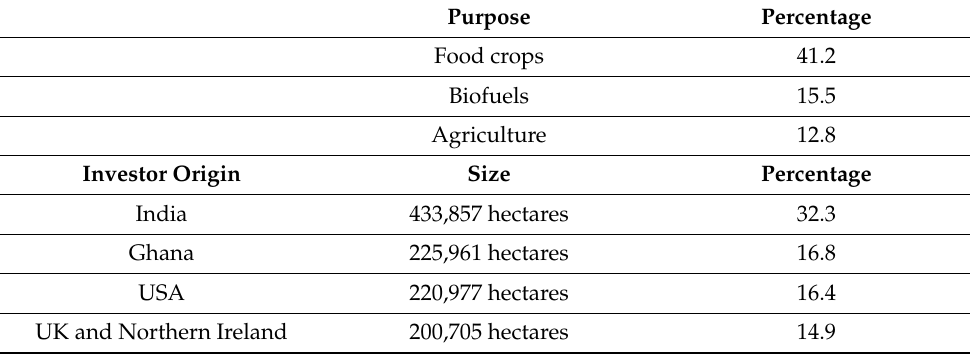
Table 1. Purpose of land acquisition and investor